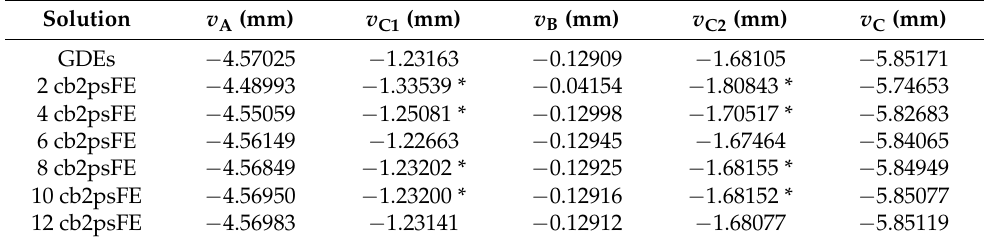
Table 1. Results of transverse displacements for several solutions and locations.